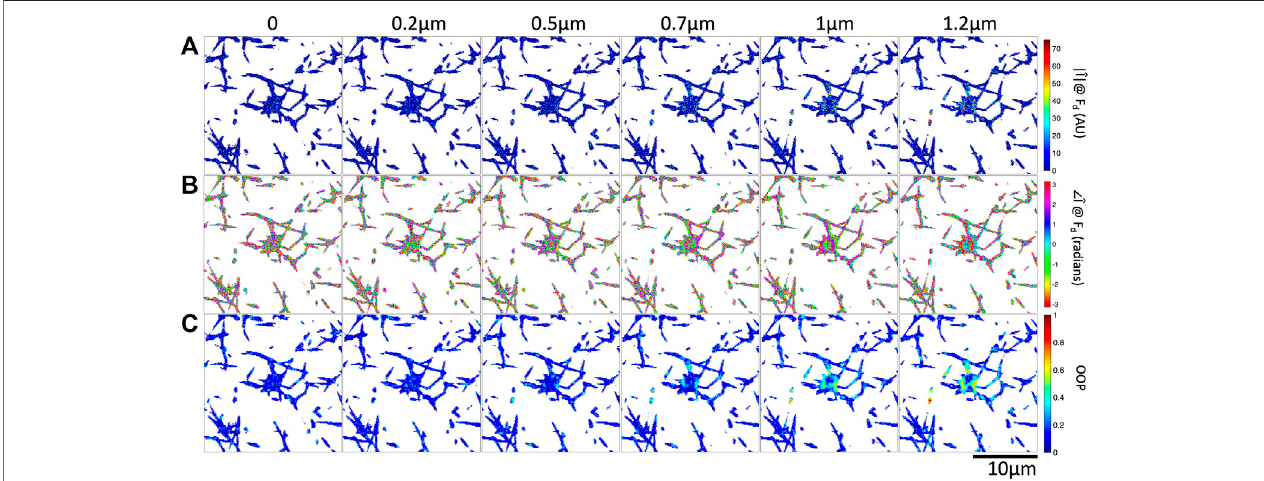
FIGURE 4 | Increasing optical tweezers oscillation amplitude results in increased Fourier magnitude and more organized Fourier phase at F d . The amplitude of optical tweezers oscillation is indicated at the top of each column. (A) Fourier magnitude at F d for a bead within a fi brin fi ber network. Corresponding (B) Fourier phase and (C) local OOP at F d are